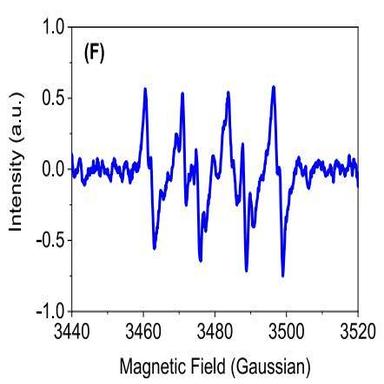
EPR spectra of irradiated (λem ca. 352 nm) aqueous DMPO (10 mM) suspensions in the following media: in the presence of Ti-γAl2O3 (A); in the presence of Ti-γAl2O3 and CHL (0.1 M) (B); in the presence of Ti-γAl2O3 and TBA (0.1 M) (C); in the presence of TiγAl2O3 and FFA (0.1 M) (D). EPR spectra of irradiated (50 W HBO lamp using a 320 nm cut-off filter) suspensions of DMPO (10 mM) in DMSO in the following media: in the presence of γAl2O3 (E); in the presence of Ti-γAl2O3 (F). 1 mg/mL of the photocatalyst was